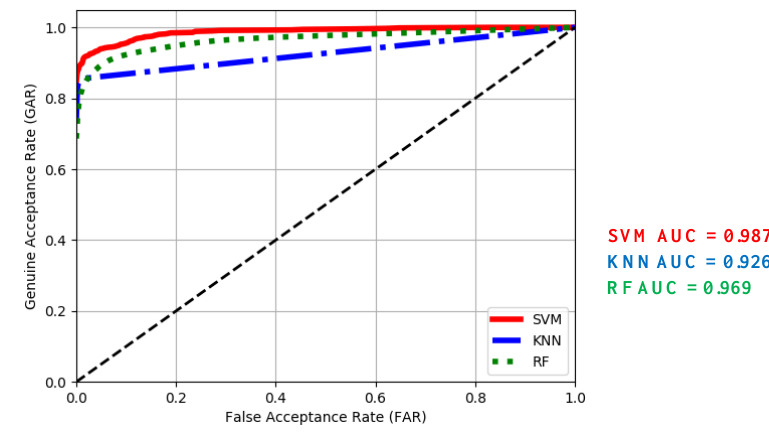
Figure 17. ROC curves of our proposed model for the 2D contact-free HKPU database.